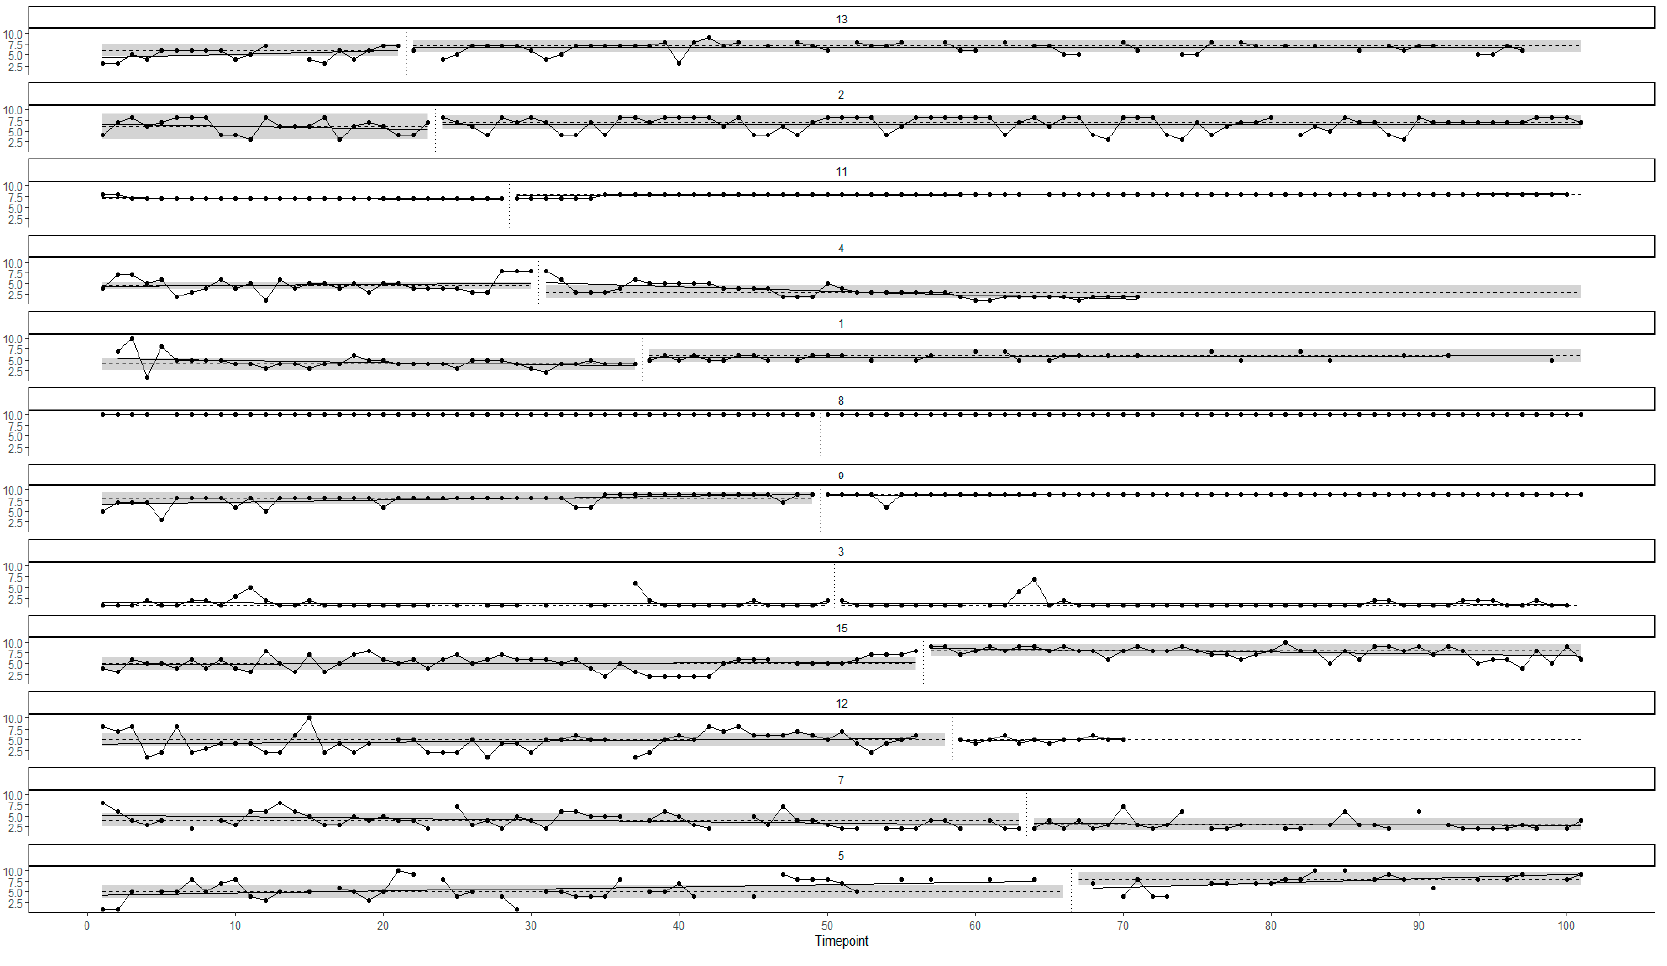
Figure A5. SCED data for all study 2 participants on daily measure of awareness. Note: Participant data are ordered via the order in which they received the intervention. Vertical dotted lines denote the data point at which the intervention was delivered. Shading denotes the one median absolute deviation from the median. Dashed horizontal lines denote the median while solid lines denote within-phase OLS regression trend lines.